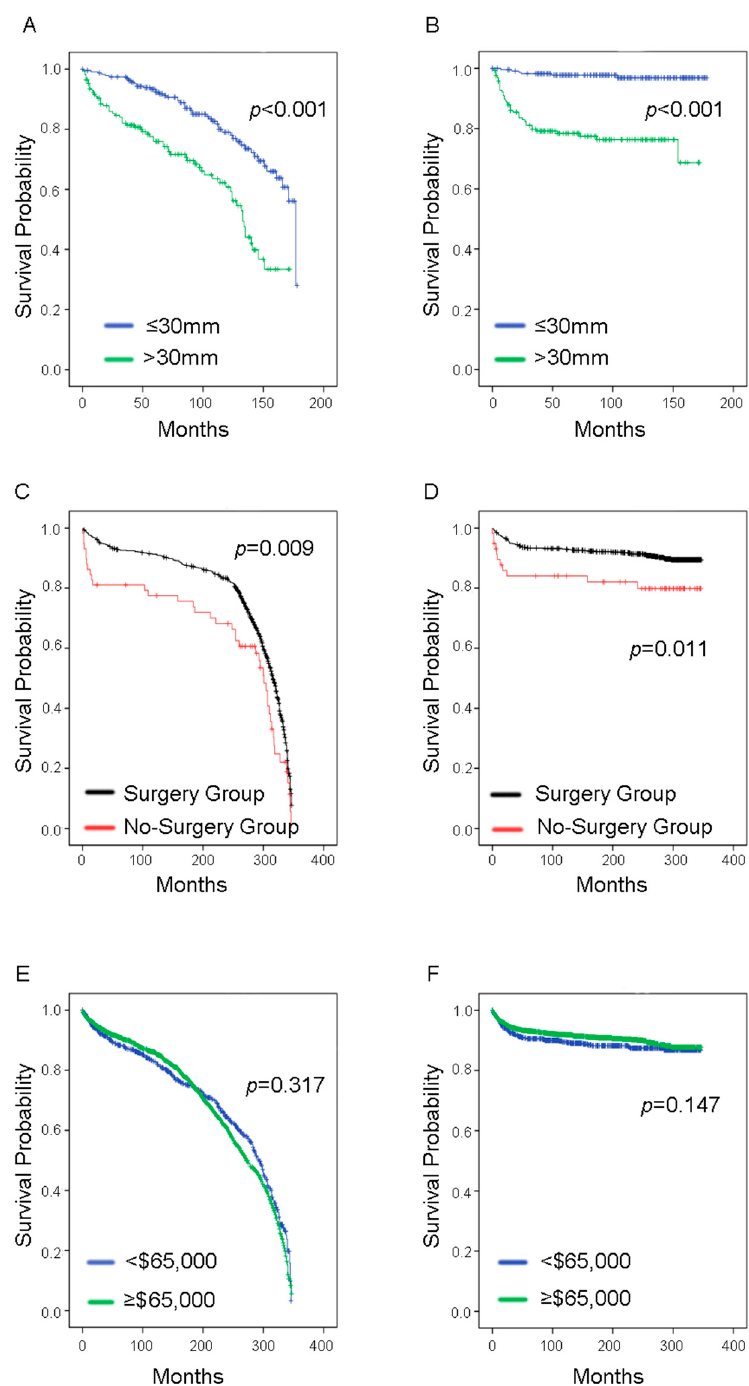
Figure 5. Survival analysis in younger bladder cancer patients with tumor size, treatment strategy, and household median income ( A , C , E ) overall survival; ( B , D , F ) cancer-specific